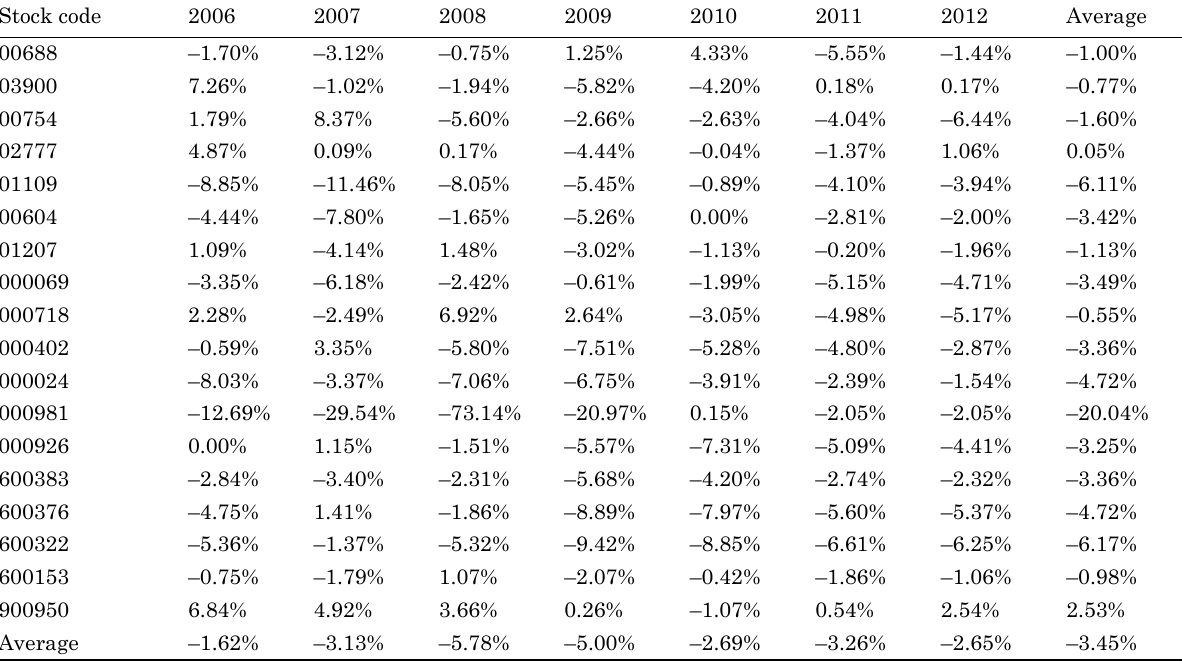
Table 7. Average POIC, WACC, ROIC – WACC and EVA of property-concentrated and multi-functional companies